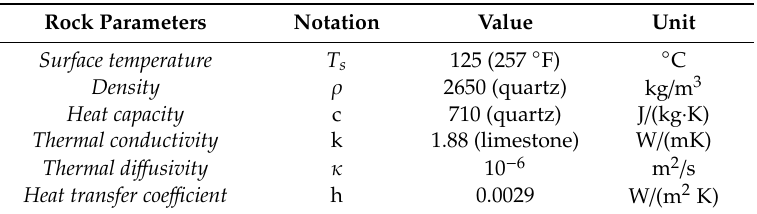
Table 4. Parameter values for the